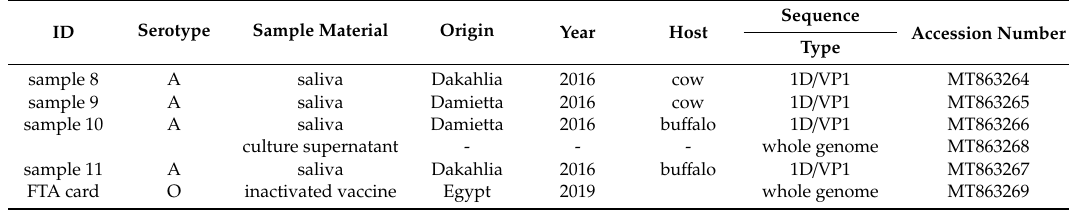
Table 1. New sequence data from this